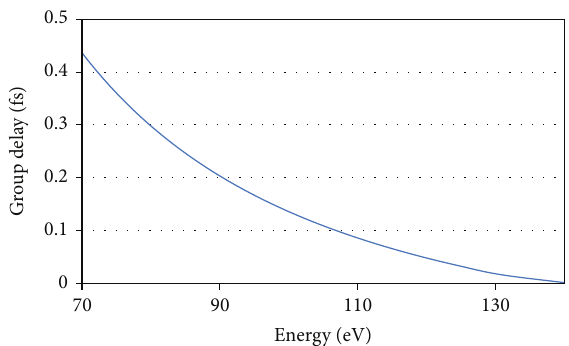
Figure 7: Group delay introduced by the XUV attosecond compres- sor with parameters of Table